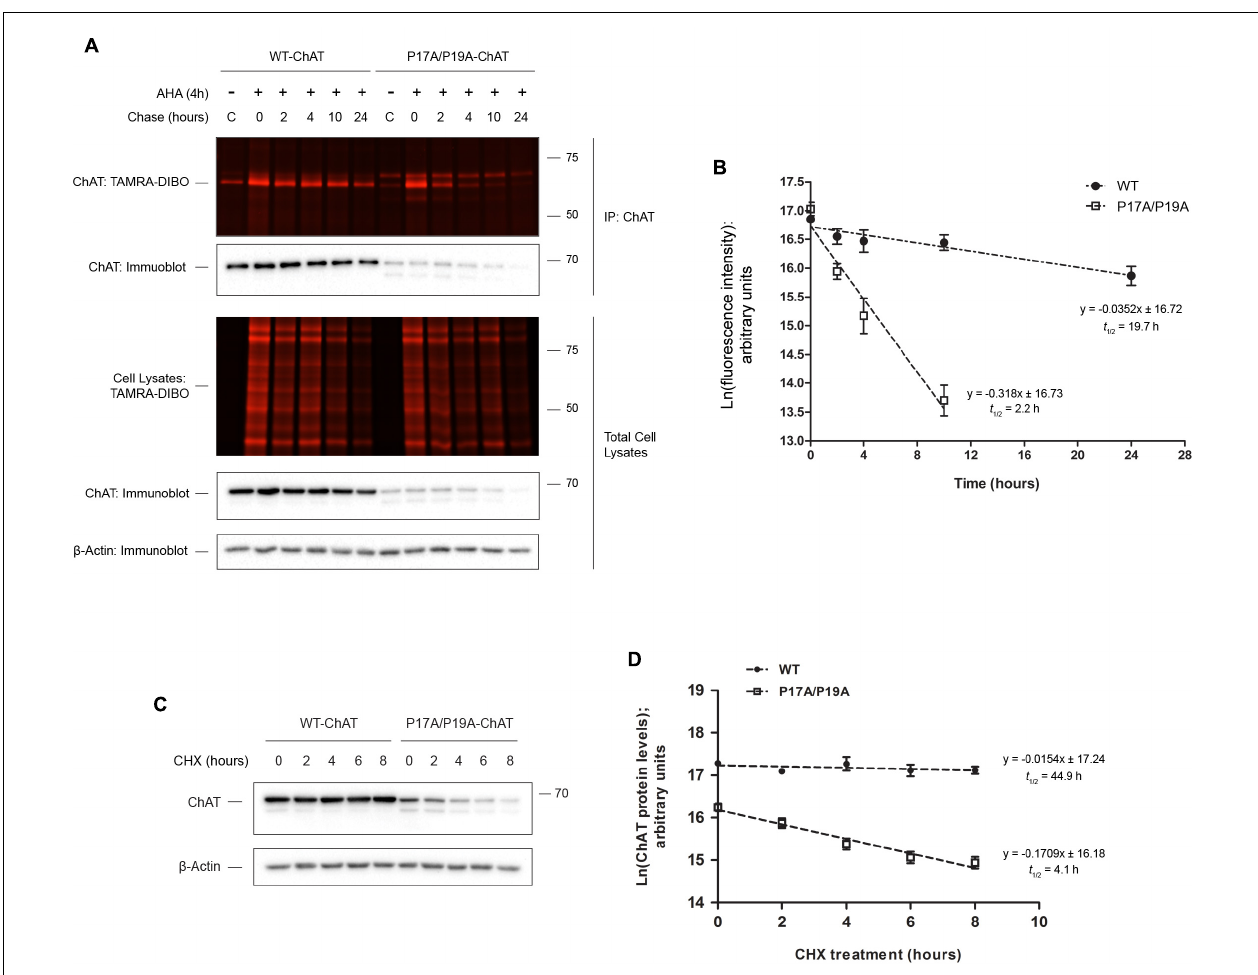
FIGURE 2 | SPAAC pulse-chase reveals that ChAT protein half-life is reduced by mutation of an N-terminal proline-rich motif. (A) Fluorescence detection of immunoprecipitated (IP) AHA/TAMRA-labeled wild-type (WT) and P17A/P19A-ChAT from transiently transfected SN56 cells following SPAAC pulse-chase (4 h AHA pulse, 0–24 h methionine chase) with the strained cyclooctyne TAMRA-DIBO. Control unlabeled cells were incubated in media with methionine (i.e., without AHA). Fluorescent AHA/TAMRA-labeled proteins from either whole cell lysates or anti-ChAT IPs were detected in resolved SDS-PAGE gels at an Ex/Em of 555/580 nm. Anti-ChAT and anti-actin immunoblots were completed on AHA/TAMRA-labeled protein samples for downstream data analysis and as loading controls. (B) Protein half-life of P17A/P17A-ChAT (2.2 h) is reduced compared to wild-type ChAT (19.7 h). ChAT fluorescence intensities from (A) were plotted on a semi-logarithmic scale and linear regression was completed to determine ChAT protein half-life. The slopes of decay for wild-type and P17A/P19A-ChAT were significantly different: F (1,41) = 110.043, p ≤ 0.0001, n = 5. A 24 h time point was not included for the quantification of P17A/P19A-ChAT half-life as the fluorescence intensity was indistinguishable from background. (C) SN56 cells, transiently expressing either wild-type or P17A/P19A-ChAT, were treated with 100 µ g/ml cycloheximide (CHX) for the time points indicated and anti-ChAT immunoblots were completed. Anti-actin immunoblots were completed as a loading control. (D) Protein half-life of P17A/P17A-ChAT (4.1 h) is reduced as compared to wild-type ChAT (44.9 h). Steady-state ChAT protein levels from (C) were plotted on a semi-logarithmic scale and linear regression completed to determine wild-type ChAT protein half-life. The slopes of decay for wild-type and P17A/P19A-ChAT were significantly different: F (1,46) = 36.802, p ≤ 0.0001, n = 5. Importantly, both methods (B,D) demonstrated that the protein half-life of P17A/P19A-ChAT is ∼ 10% that of wild-type ChAT. Adapted with permission from Morey et al.